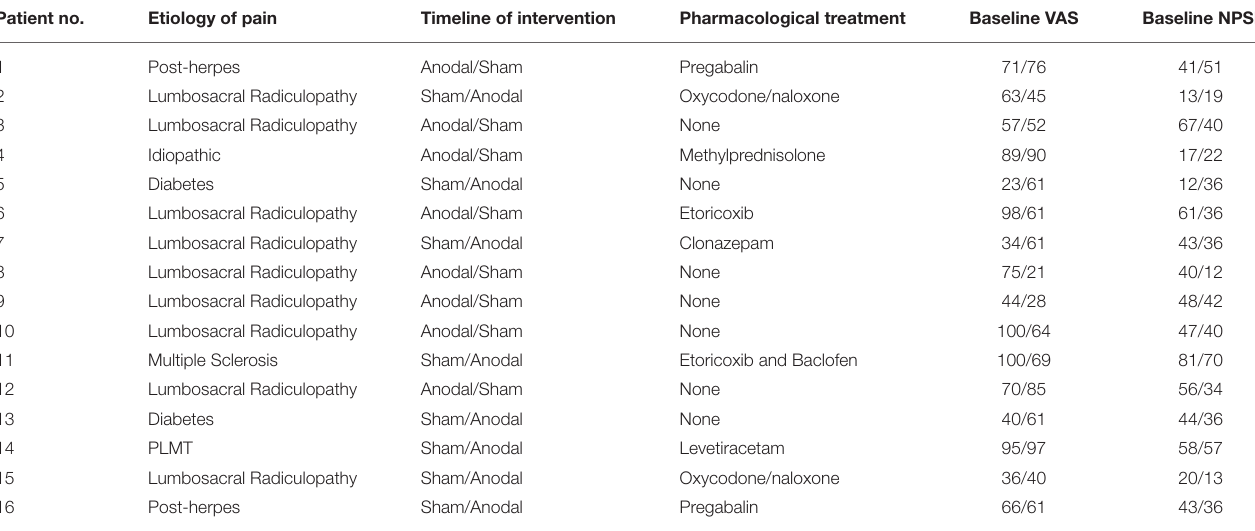
TABLE 1 | Demographic characteristics of the subjects. Patient